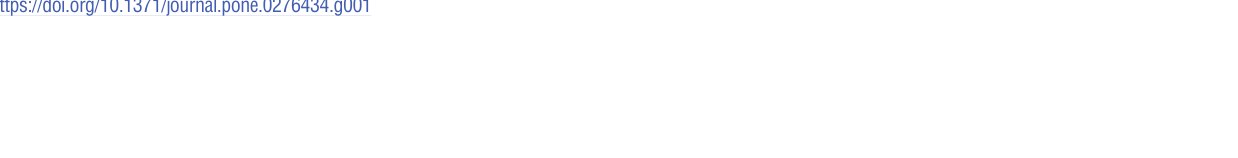
PLOS ONE | https://doi.org/10.1371/journal.pone.0276434 October 21,